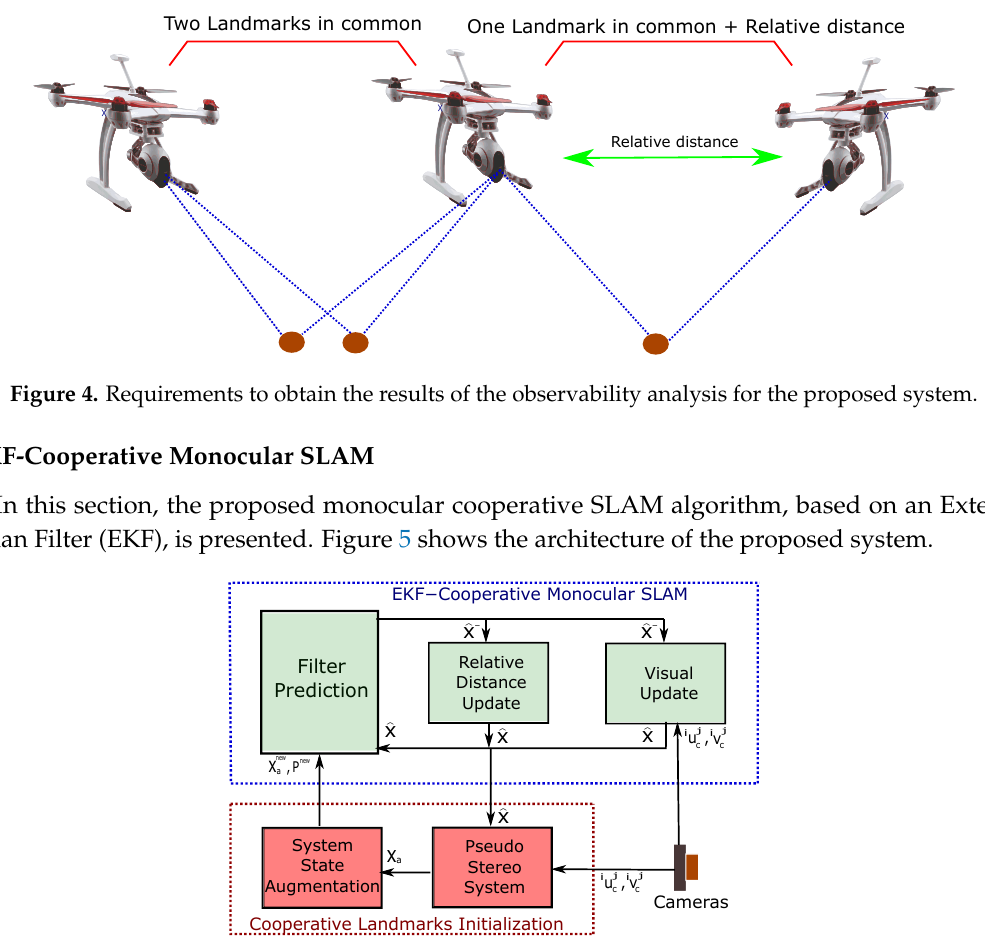
Figure 5. Block diagram showing the architecture of the system: EKF-cooperative monocular